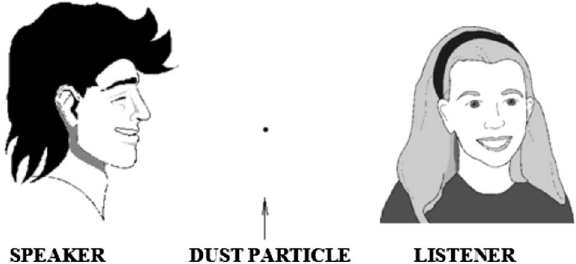
FIG. 4. Picture available to students for better understanding of the situation and for optional drawing during discussion related to context 1 in interview protocol.